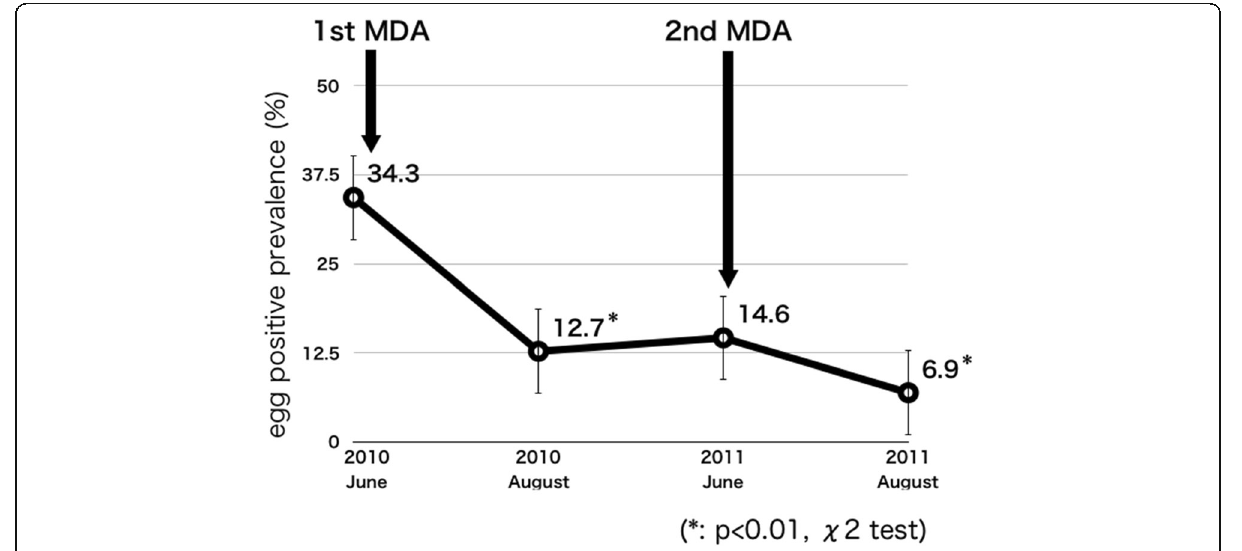
Fig. 4a, b, those are the process of egg-positive prevalence by age groups in 2013. The youngest subject among the egg-positive group was a 2-year-old boy. Praziquantel 40 mg/kg was administered to 728 participants (52.3%) more than 4 years old by DOTS immediately after urine exam- ination. We confirmed that no one experienced any side effects from the praziquantel administration.